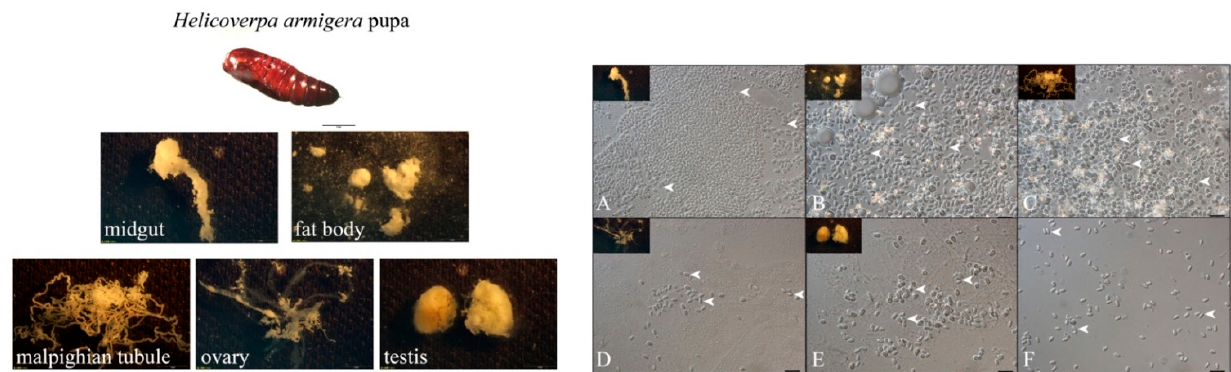
Figure 2. Microscopic observation of NbCQ1 infections in H. armigera pupa tissues. ( A ) midgut, ( B ) fat body, ( C ) malpighian tubules, ( D ) ovary, ( E ) testis, ( F ) hemolymph. The bar indicates 10 µ m. The arrowhead shows the NbCQ1 spore.